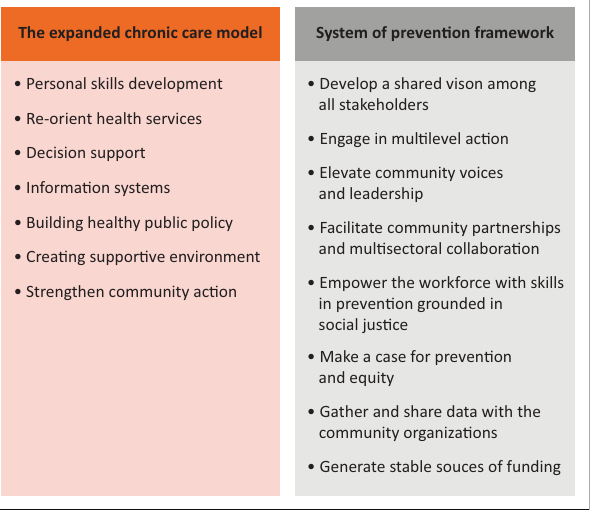
The expanded chronic care